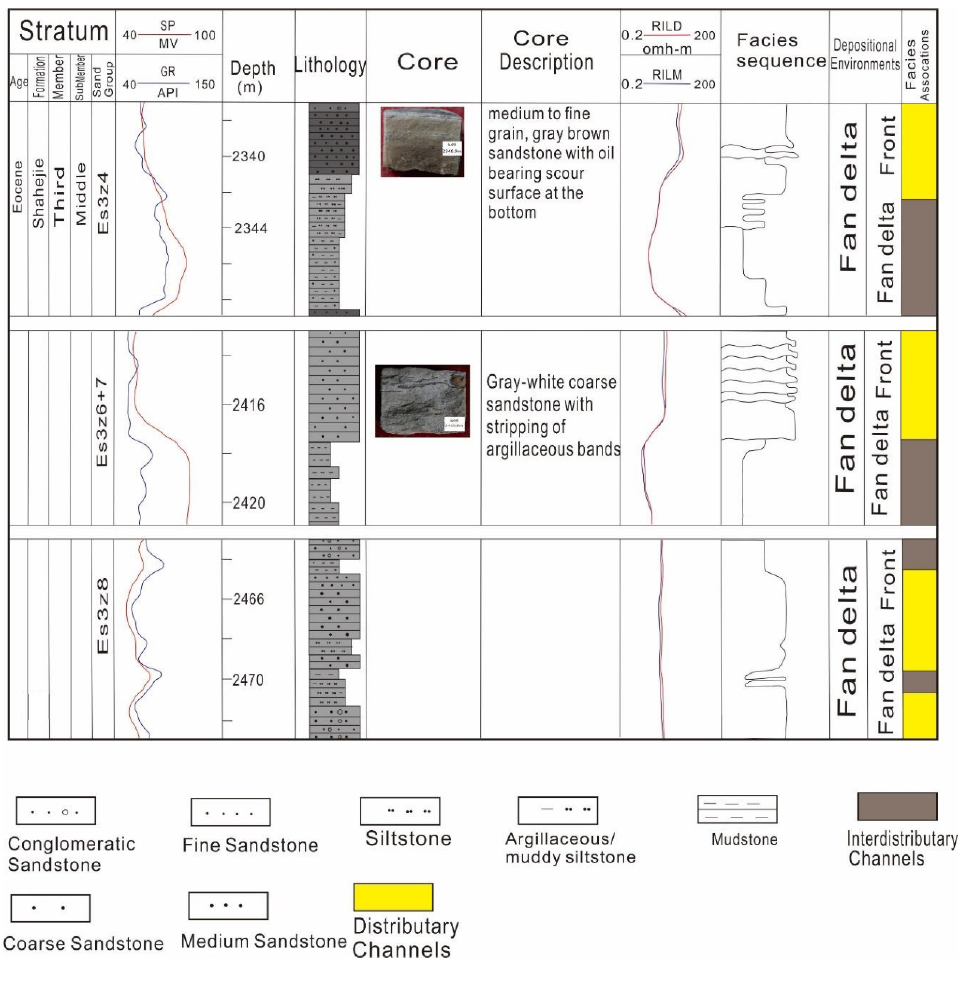
Figure 7. Core wells 49 in the study area, which shows trend of log suits with lithology, core and indication of sedimentary facies.